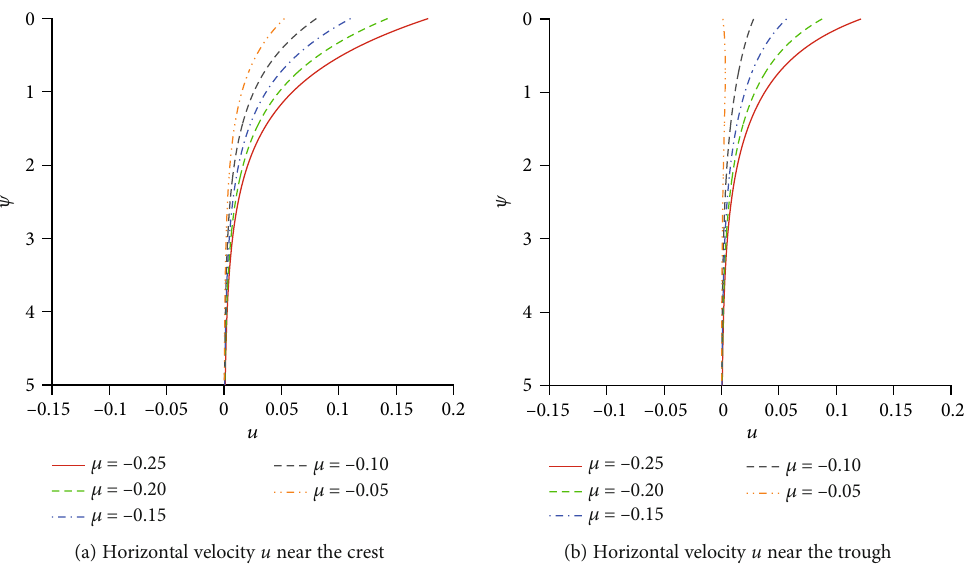
Figure 8: The in fl uence of the aiding shear currents on horizontal velocity pro fi le u of propagating periodic waves for di ff erent vorticity parameter μ by means of c = − 0 : 4 . Solid line: μ = − 0 : 25 ; dashed line: μ = − 0 : 20 ; dash dot line: μ = − 0 : 15 ; long dash line: μ = − 0 : 10 ; dash 0 dot dot: μ = − 0 : 05